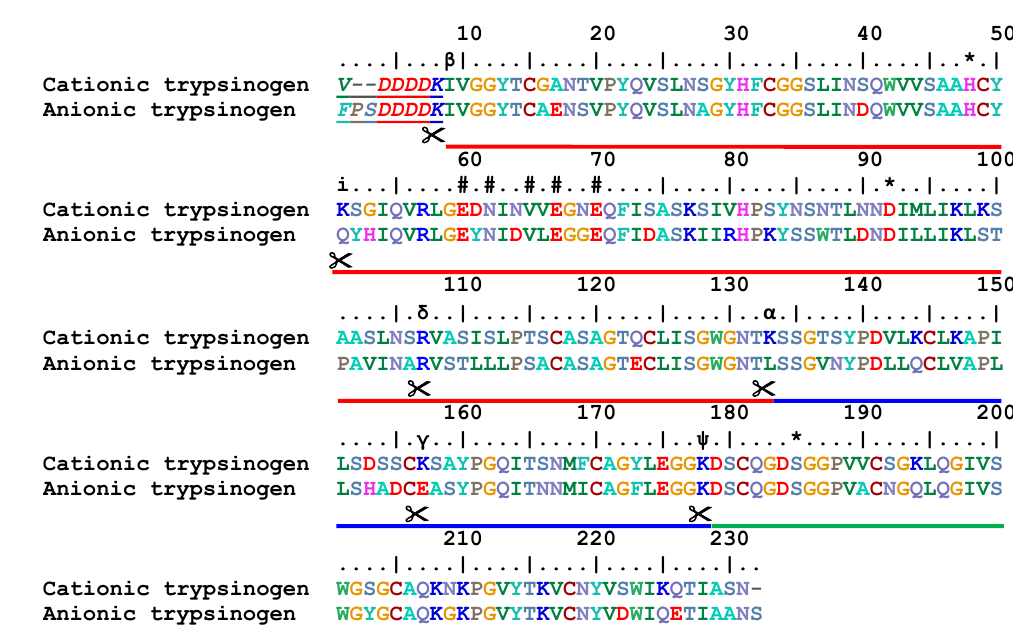
Figure 1. An alignment of the cationic and anionic bovine trypsinogen sequences. Italic letters and a thin underlining at the beginning of the sequences highlight the activation peptides, which are cleaved off during the trypsinogen conversion to mature trypsin. In the ruler line, asterisks (*) indicate active-site residues (the charge relay system, also catalytic triad) and hash (#) symbols mark calcium-binding residues. Greek alphabet letters indicate the cleavage sites in the active single-chain β -trypsin (223 residues), which yield the other trypsin proteoforms ( α , γ , δ , and ψ ) upon autolysis. The small-case letter ‘i’ denotes the cleavage site leading to an inactive trypsin variant. All above mentioned cleavage sites are additionally highlighted by a symbol of scissors. Thick red, blue, and green lines indicate individual ψ -trypsin chains. The alignment was made using BioEdit 7.2.5 with trypsinogen sequences obtained from the UniProt database. The accession numbers are P00760 (TRY1_BOVIN, cationic) and Q29463 (TRY2_BOVIN, anionic). The numbering refers to anionic trypsinogen. For cationic trypsinogen, it is shifted towards the canonical numbering by two units up because of the alignment.